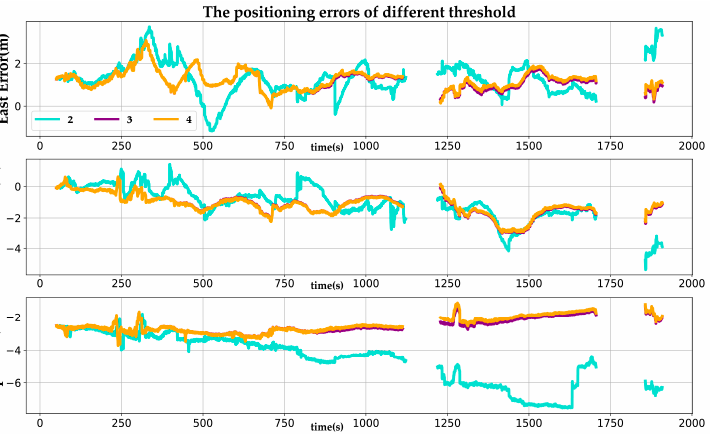
Figure 12. The positioning errors of different line feature tracking thresholds.